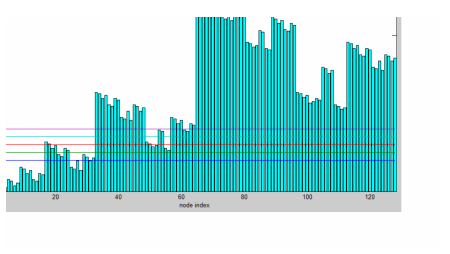
Figure 5. 4 overlapped periods from one of the analyzed signal. Top - example of metrics for a non-steady subinterval . Bottom the correspond- ing estimated noise.